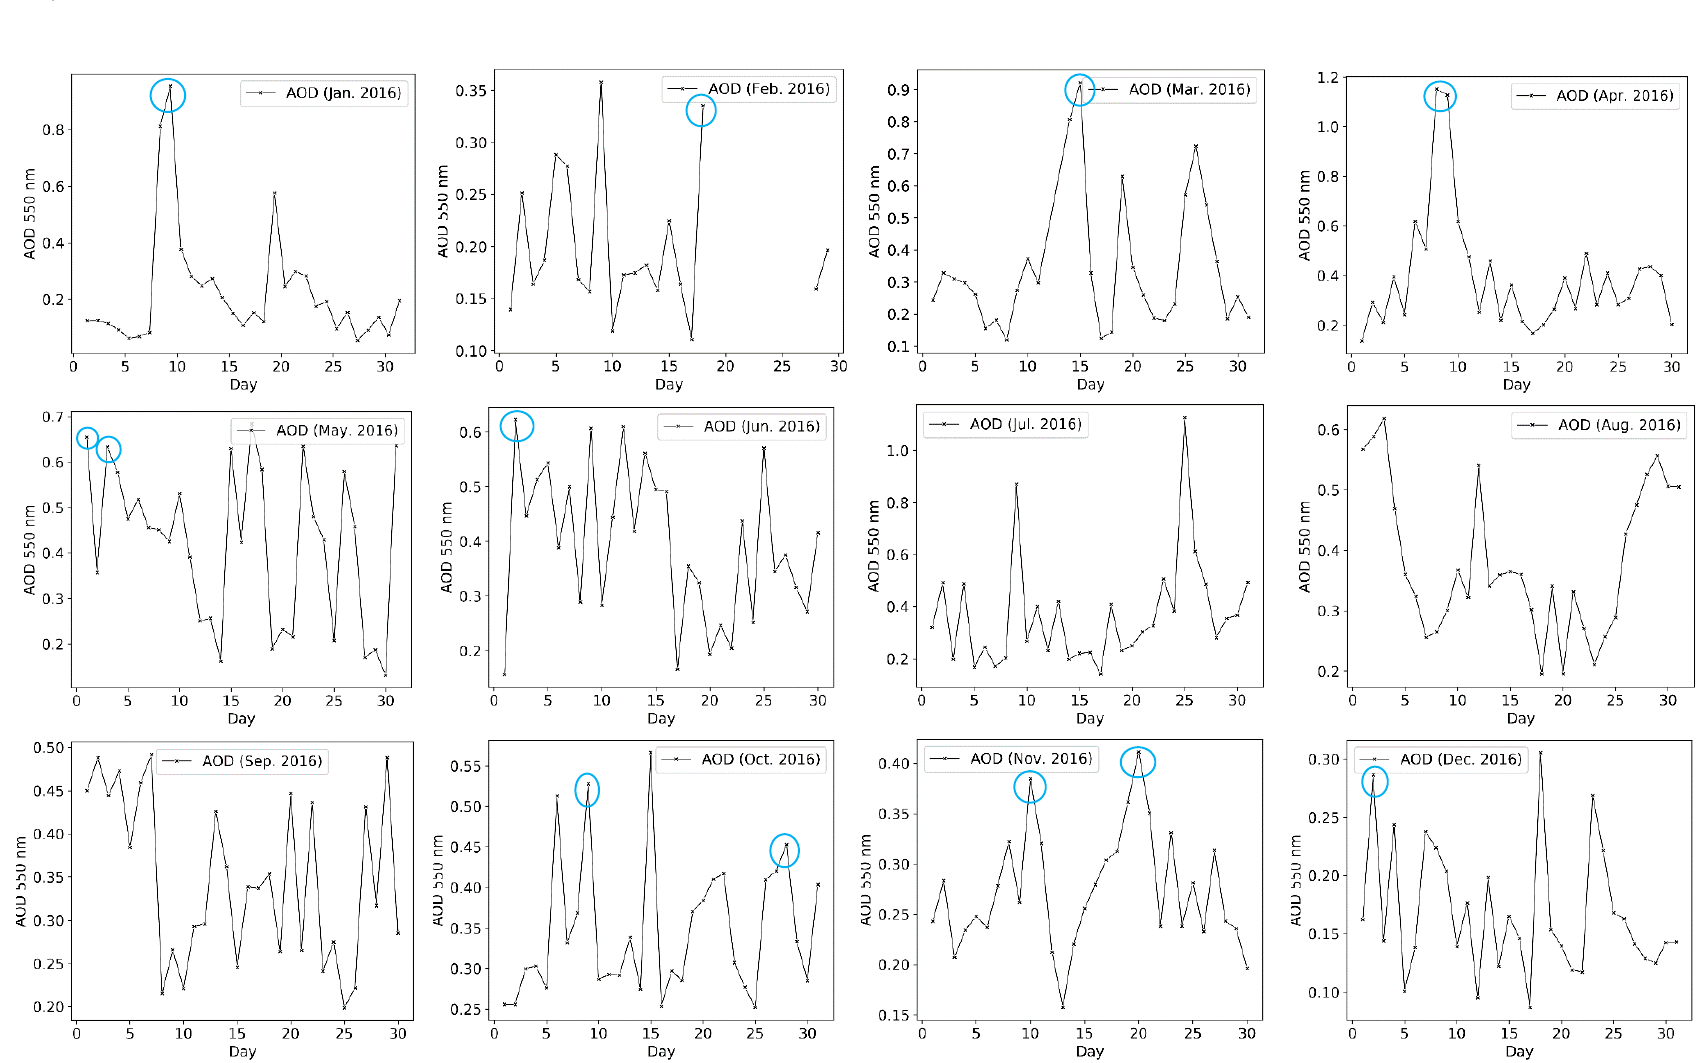
Figure 11. Monthly variations of MODIS AOD in 2016 over Egypt; blue circles highlight the dusty days obtained from EEAA monitoring networks that match AOD peaks.